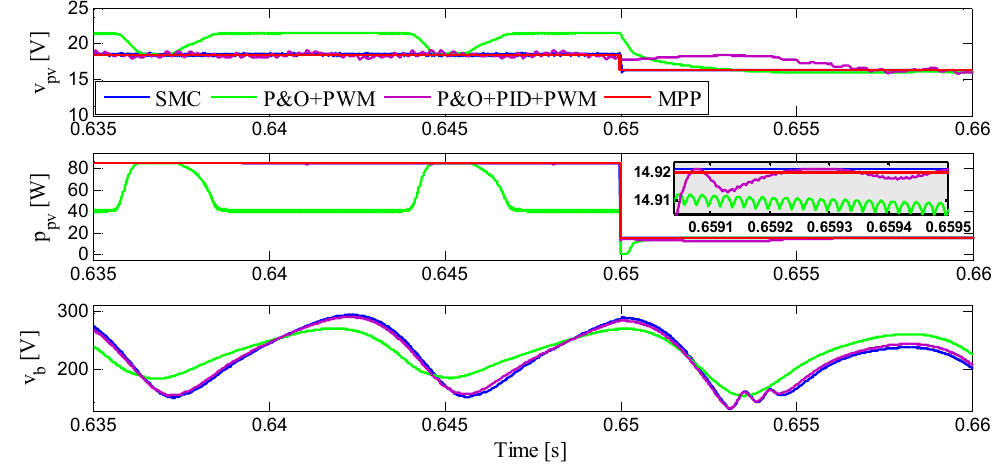
Figure 20. Performance comparison between the SMC and conventional P & O-based solutions considering large DC-link voltage oscillations.